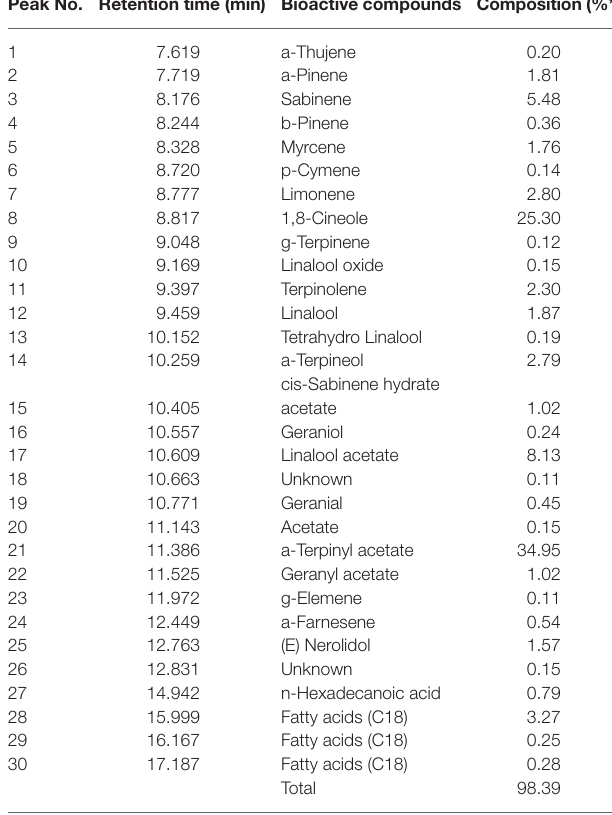
TABLE 1 | GC-MS quantification of Elletaria cardamomum bioactive